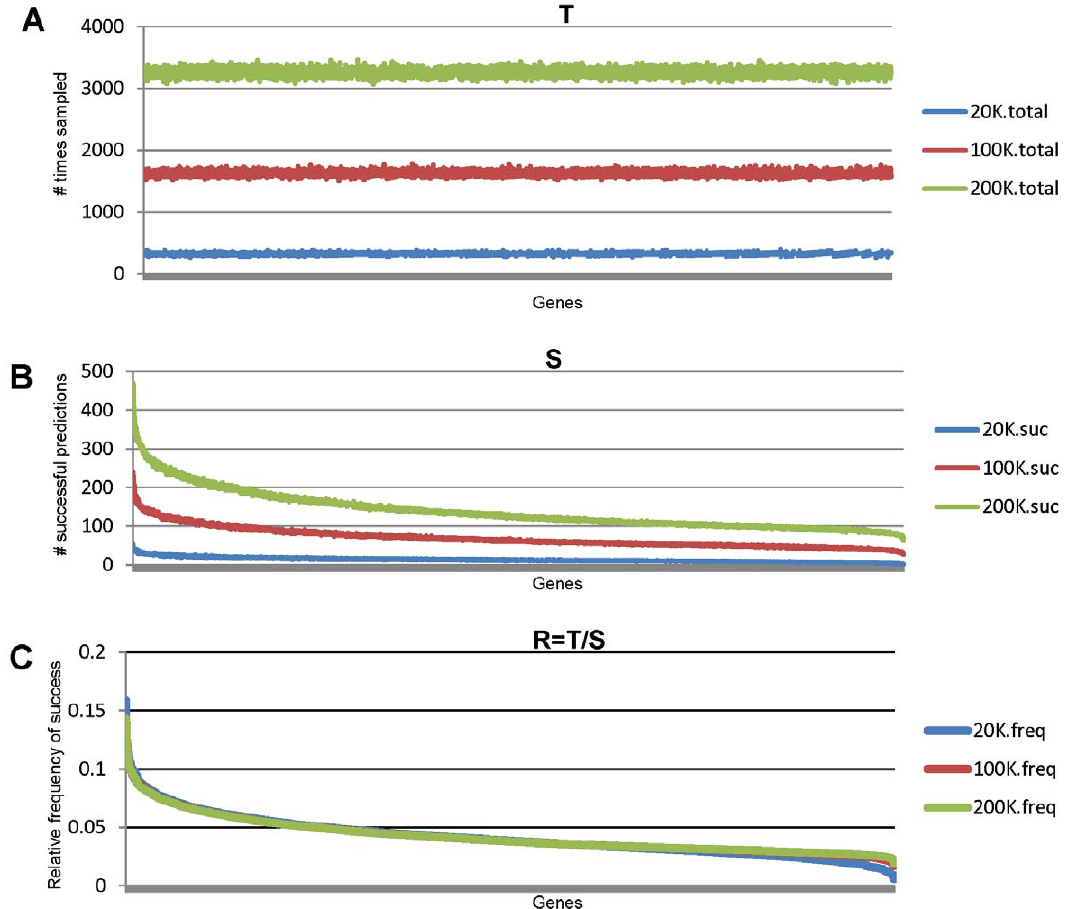
Figure 2. Analysis of sampling distribution in the predictive power enrichment matrix. ( A ) A random number generator with a uniform distribution was used so that each of 4000 features (genes) had equal chances to be sampled. Y axis is the total # of times a gene was sampled, represented as T. ( B ) A prediction was called a success if overall error rates , a , which is 20%. Y axis is the total # of times a gene was included in a successful modeling, denoted as S. ( C ) Y axis is the Relative Success Rate that a gene was used in successful modeling, computed as R=S/T, which is a metric to measure the predictive power of the gene.